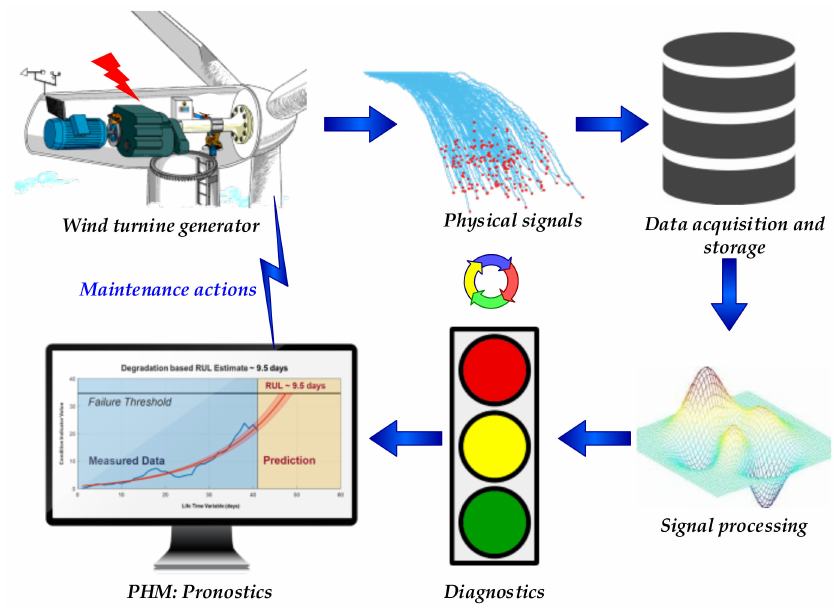
Figure 4. Description of a wind turbine condition monitoring